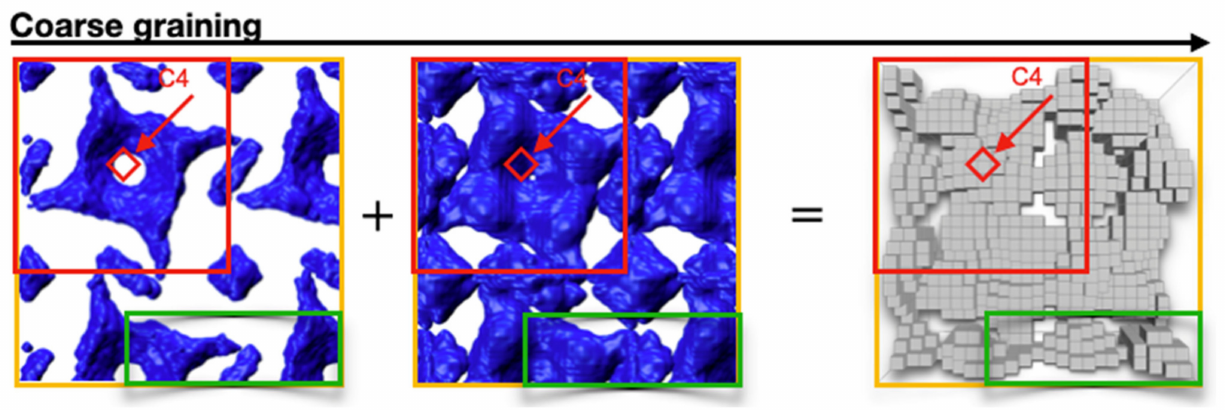
Figure 3. Coarse graining concept, the box model: Core and hull models are superimposed and then rasterized. The coarse-grained model is given by grey boxes of 1 nm side